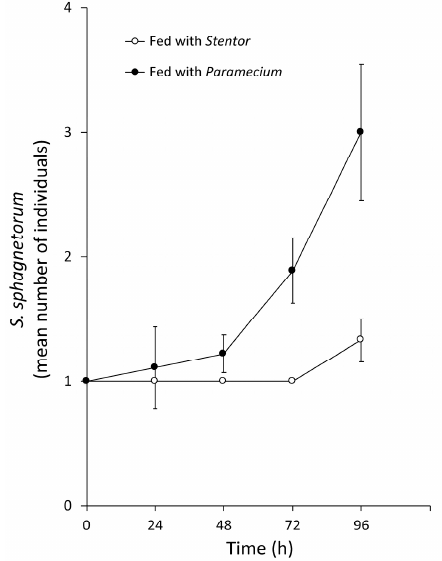
Figure 7. Comparison between the growth curves of S. sphagnetorum fed with S. polymorphus and fed with Paramecium multimicronucleatum . One S. sphagnetorum was mixed with 50 cells of S. polymorphus or with 100 cells of P. multimicronucleatum , a non-toxin producing ciliate as a control. The specimens of S. sphagnetorum were counted for 96 h. Each point denotes the mean ( ± SE) of nine independent